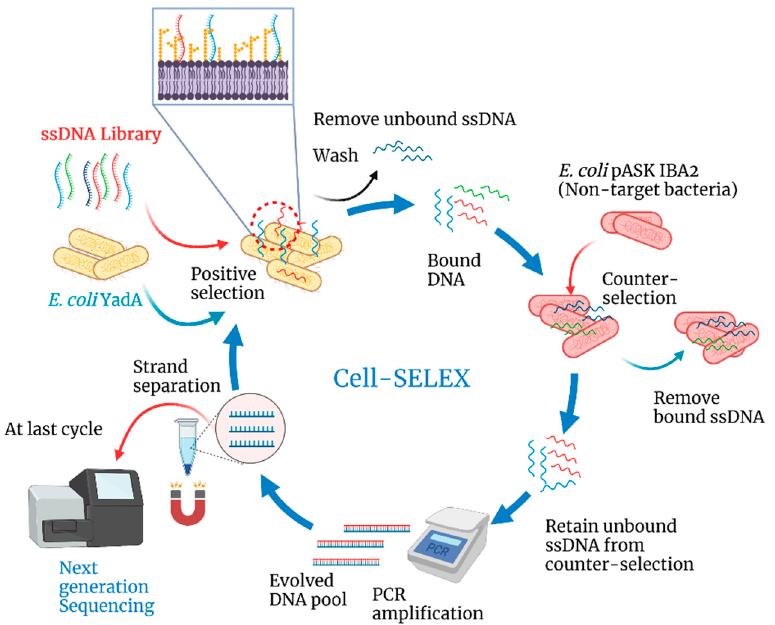
Figure 1. Schematic illustration of the steps in the cell-SELEX process to isolate an aptamer pool with high-affinity to YadA adhesin over 8 cycles of evolution starting with a ssDNA random library. Created with BioRender.com (accessed on 22 July 2022).